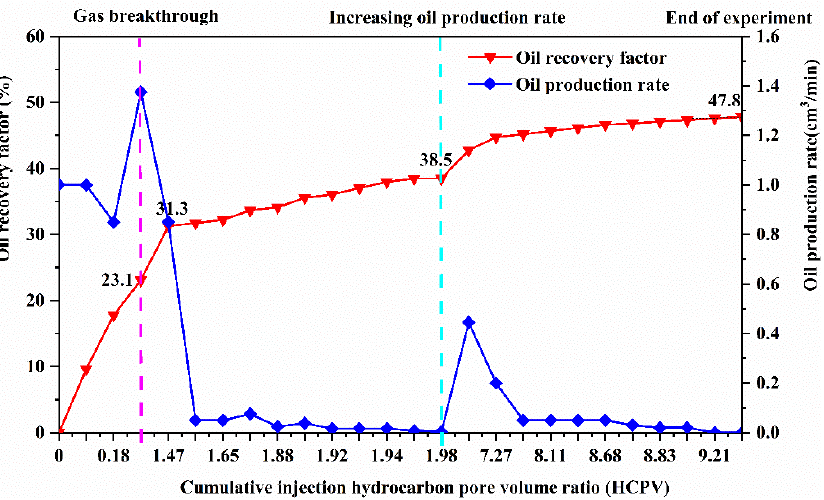
Figure 12. Relationship between cumulative injection hydrocarbon pore volume ratio (HCPV), oil recovery factor, and oil production rate.